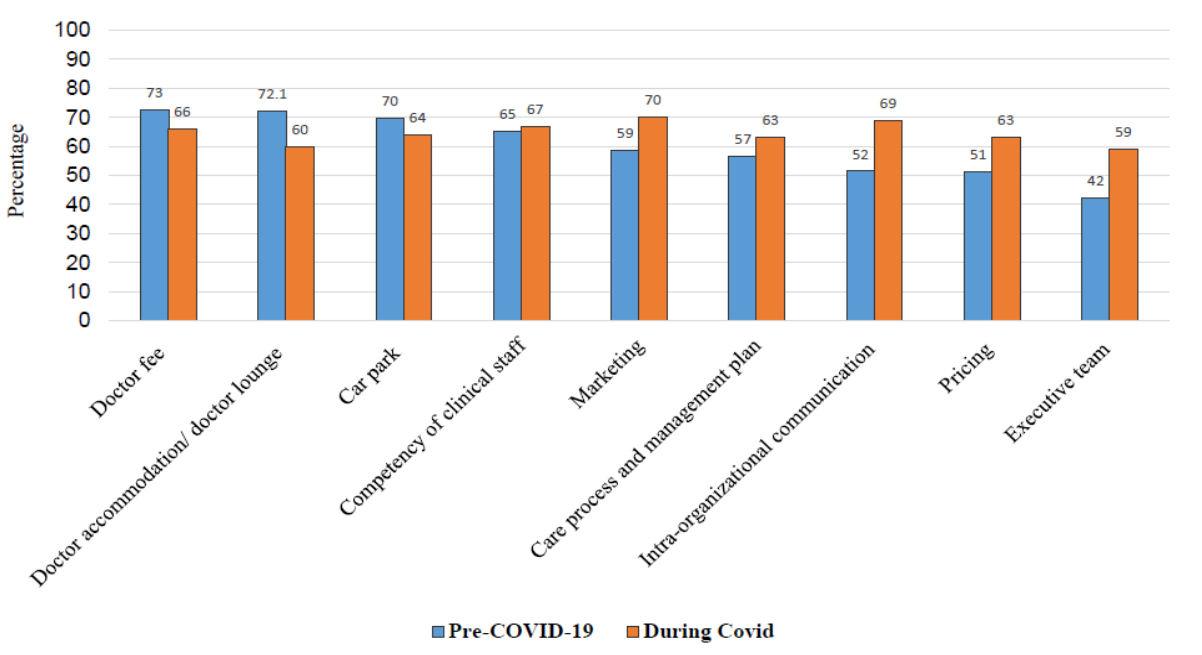
Figure 1. Responses to Question 39, “What would you like to see improved in the next 12 months?”.